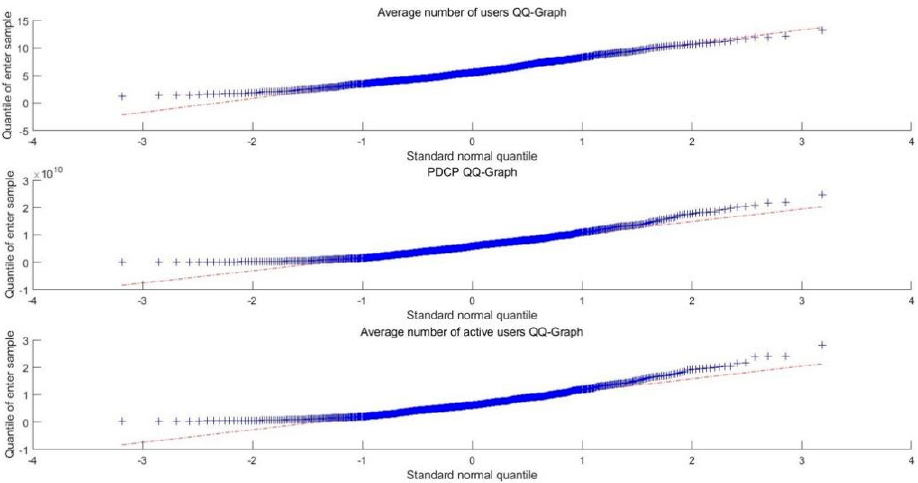
Figure 3. Regarding the QQ chart of various KPI data.